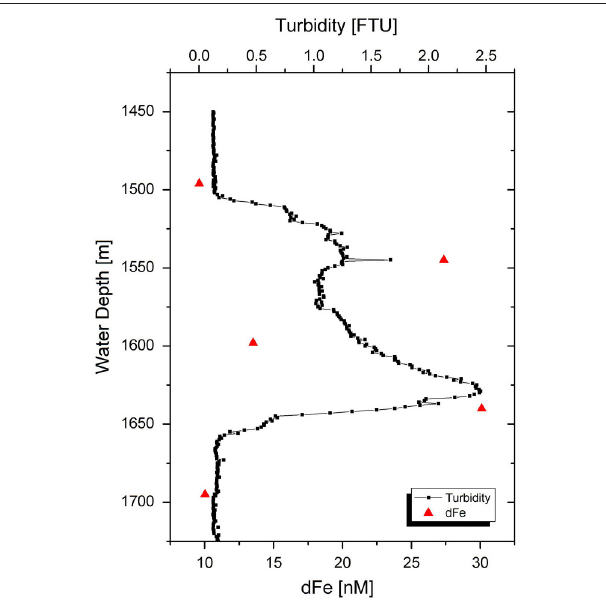
FIGURE 4 | Turbidity signal of non-buoyant plume 30 CTD above the Nifonea vent field. Red triangles display dFe concentrations in the approximate depths of sampling. Bottles were closed in 1500, 1550, 1600, 1650, and 1700m water